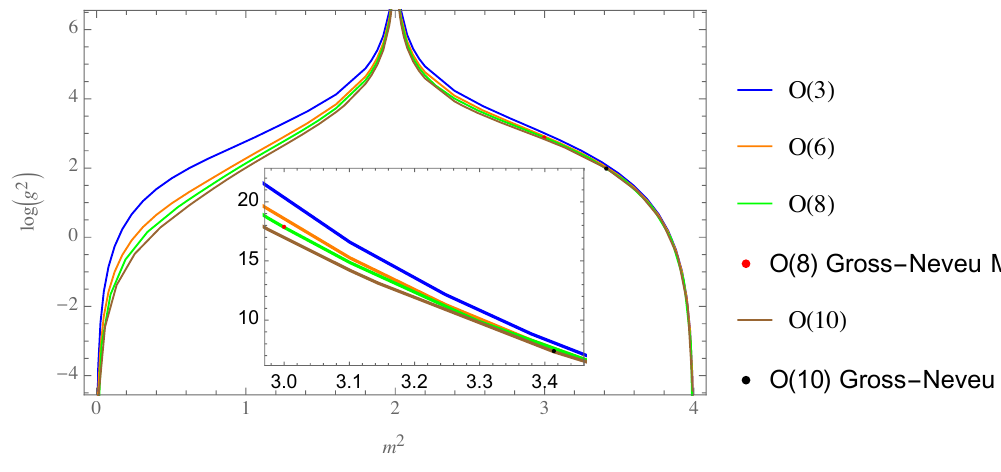
Figure 5 . Numerical bounds and the Gross-Neveu model points. This is a bound for the coupling to an antisymmetric tensor in the presence of a scalar bound state of the same